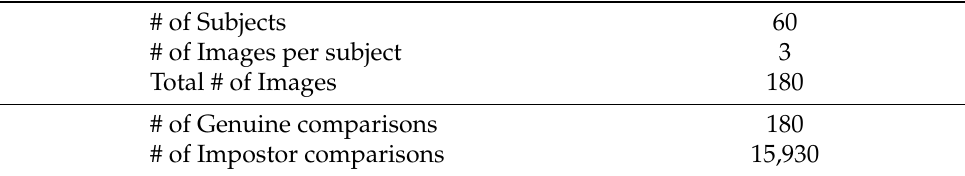
Table 2. Comparison (matching) summary for the dataset in Figure A1.